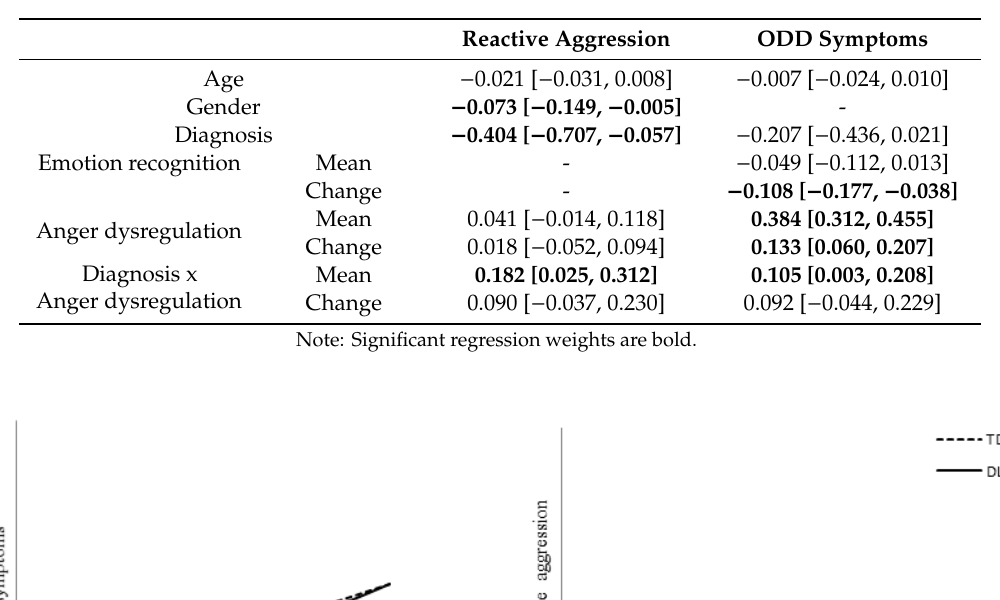
Table 3. Regression weights with 95%CI for best-fitting models with emotion recognition and anger dysregulation predicting reactive aggression and Oppositional Deviant Disorder (ODD) symptoms. Reactive Aggression